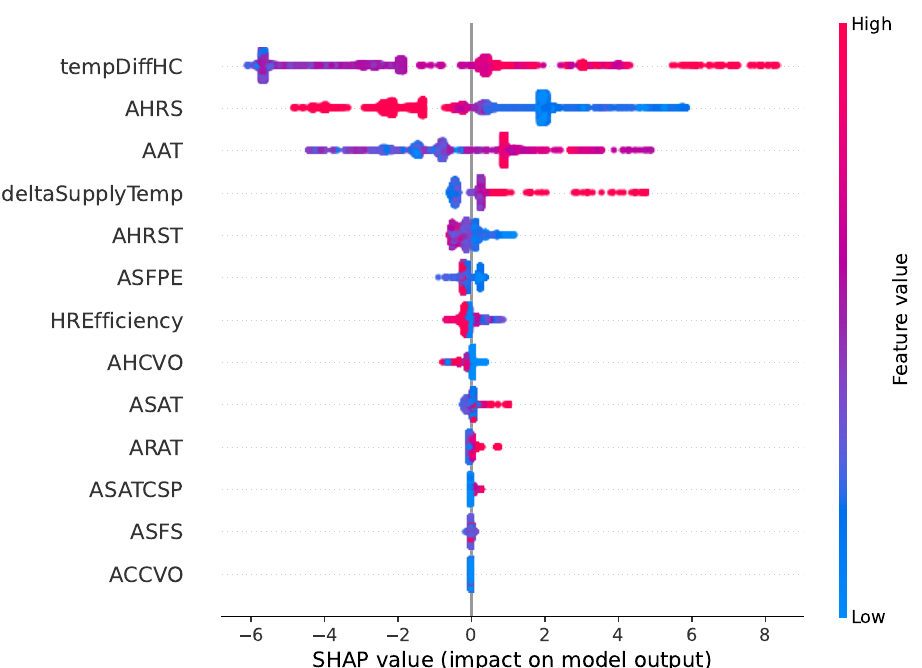
Figure 6. Summary of the effects of all the features on the XGBoost model prediction of the fault type “Heating coil valve leak”. The SHAP values show the impact of each feature on the model output. The color represents the feature value (red shows a higher impact while blue shows a lower impact). For example, we can observe that the higher the deltaSupplyTemp (difference between supply air temperature and its setpoint), the more likely it is to indicate a heating coil valve leak.